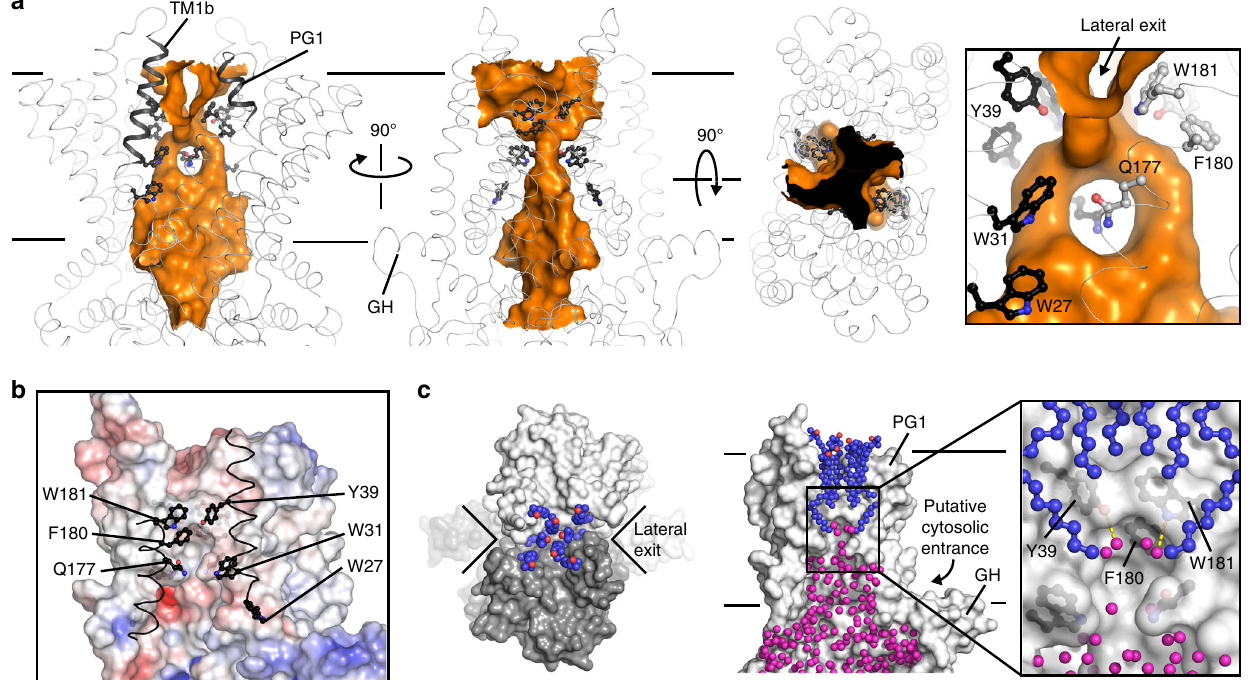
Fig. 2 WzmWzt forms a large transmembrane channel in the ATP-bound conformation. a Surface representation of the AaWzmWzt EQ channel calculated with a 2.5 Å-radius probe shown as an orange surface. Right panel, zoomed in view of the channel near the periplasmic lateral exit. Aromatic residues lining the channel are shown as black and gray ball-and-sticks for different Wzm protomers. The transporter backbone is shown as a gray ribbon. b Electrostatic surface potential of the channel calculated with the APBS plugin in PyMOL (scale − 5.0 (red) to + 5.0 (blue) kT/e). TM1 and 5 of the opposing Wzm protomer are shown as a black ribbon with selected aromatic residues in ball-and-sticks. c LDAO molecules occupy the periplasmic opening of the channel. Left: Periplasmic view of AaWzmWzt EQ . Right: The AaWzmWzt EQ channel is shown with one WzmWzt half transporter removed. Crystallographically resolved water molecules inside the Wzm channel are shown as magenta spheres. AaWzmWzt EQ is shown as a gray surface and LDAO molecules as blue and red